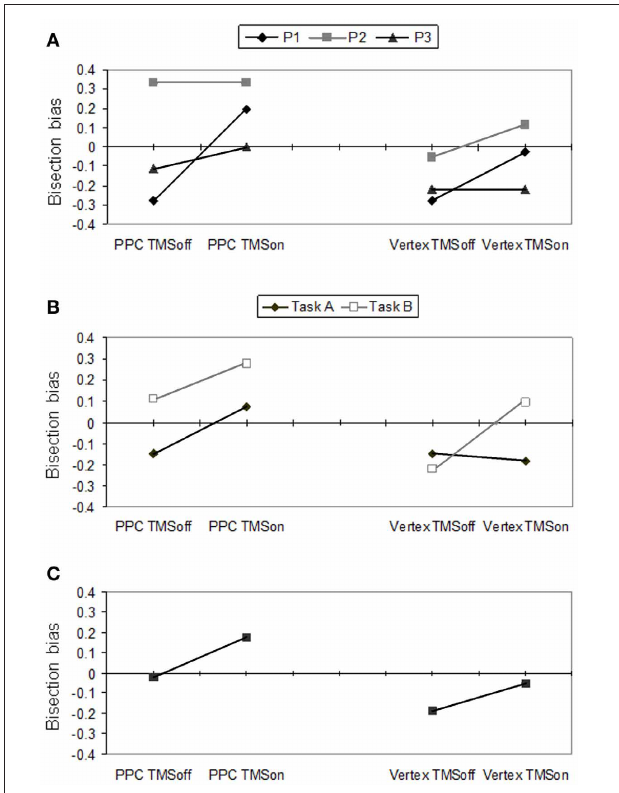
FIGURE 2 | Behavioral effects according to Fierro et al.’s (2001) score. Right PPC and vertex stimulation for on vs. off trials. (A) Individual scores for P1, P2 and P3, averaged across tasks A and B. (B) Mean participants’ scores for task A and B. (C) Mean participants’ scores pooled across tasks.